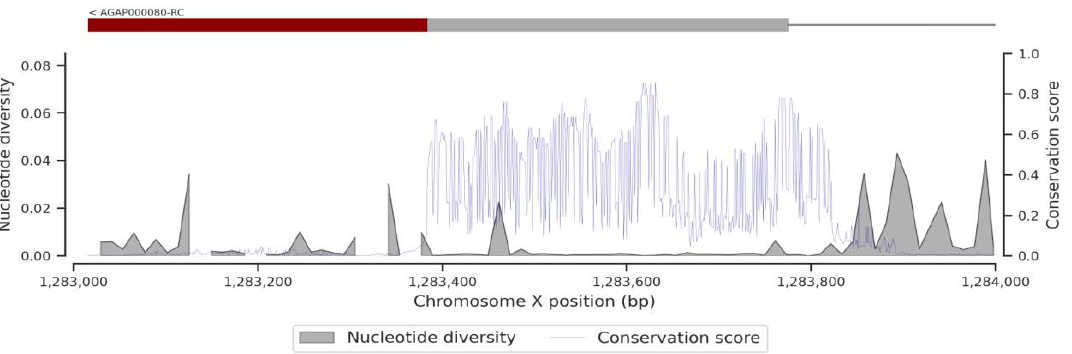
Figure A9. Conservation score and nucleotide diversity in a window of 12 bp within the zinc-finger C (ZnFC) region of the Fruitless gene; upper figure shows the ZnFC region (the rectangle corresponds to the exonic region, the dark red end is the 3 prime UTR region, and the simple line is the intronic region); lower figure shows the conservation score (blue line) and the nucleotide diversity (dark fill) plot.